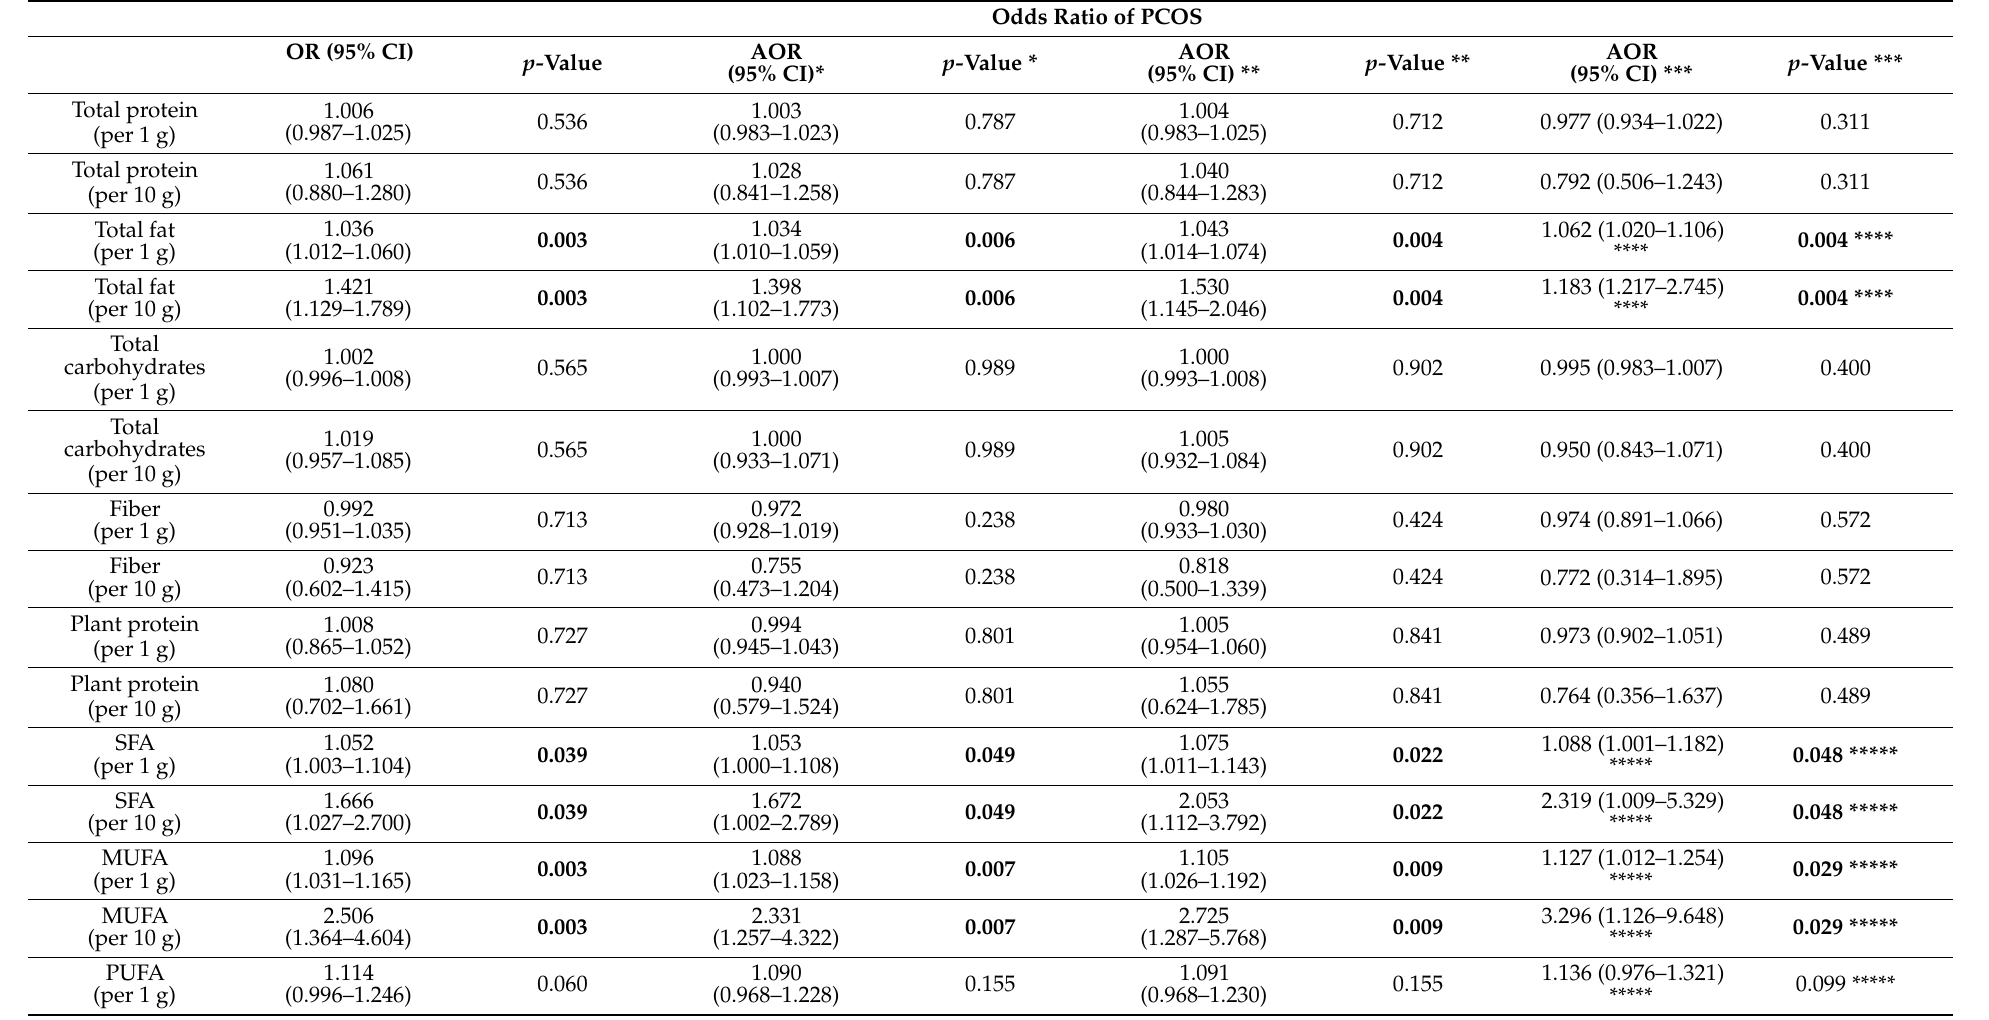
Table 4. The odds ratio of macronutrients intake, GI and PA and the risk of